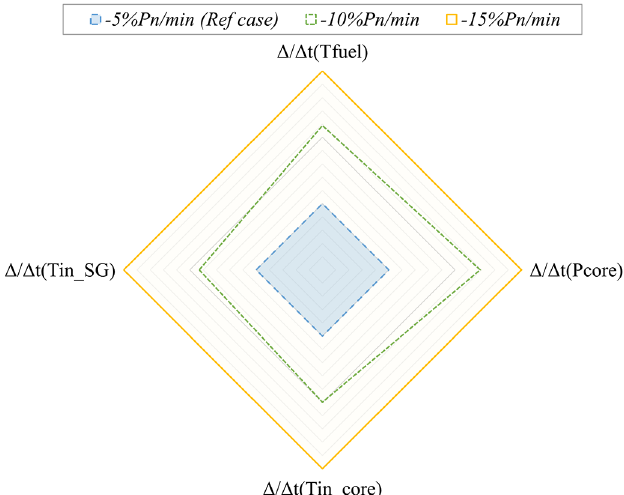
Fig. 12. Radar for two constrained transients with a magnitude of